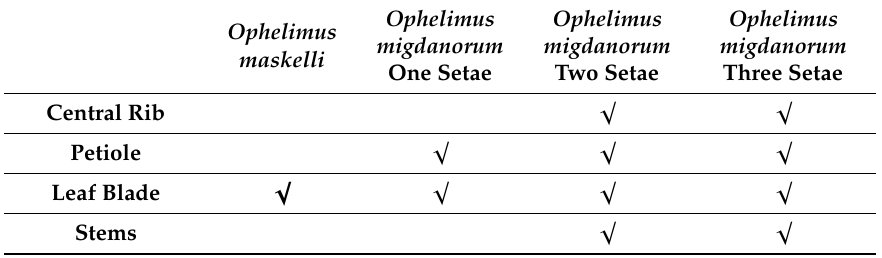
Table 2. Emergence of adults of Ophelimus migdanorum , obtained from the areas: Midrib, petiole, leaf blade, and stem. Comparison shown with Ophelimus maskelli , according to Branco and Protasov’s decription. Oph 1 Seta: Ophelimus migdanorum with one seta, and the same for two and three setae, √ respectively. : Checkmark shows the places in which they emerged.